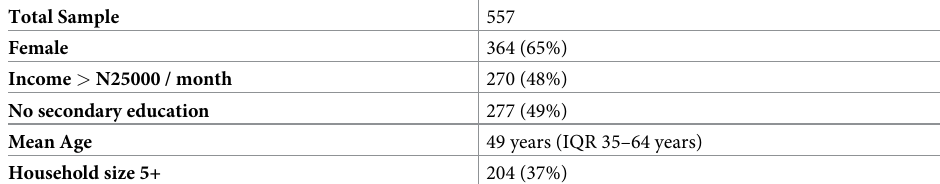
Table 2. Sociodemographic characteristics of respondents.